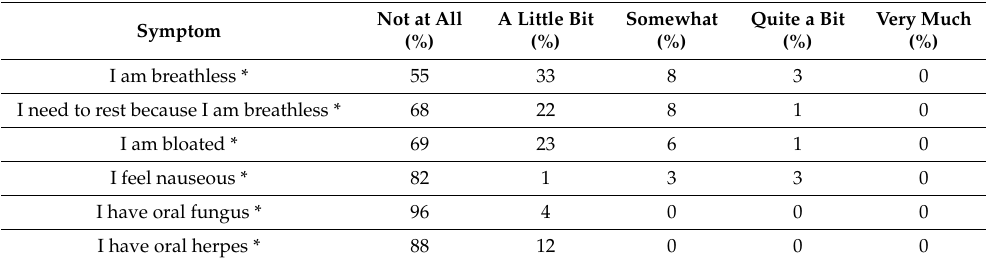
Table 2. Symptom occurrence and symptom distress among 79 heart recipients one to five years after heart